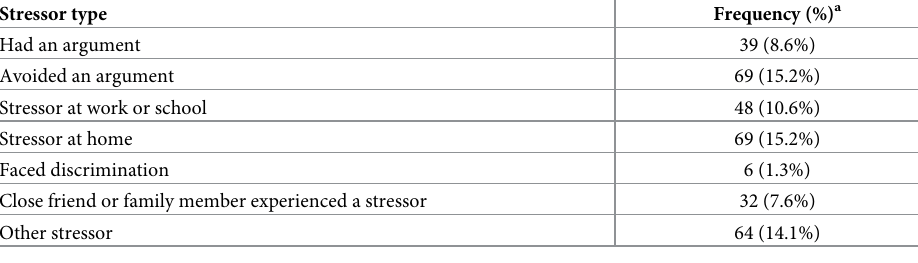
Table 3. Frequencies of stressors reported.